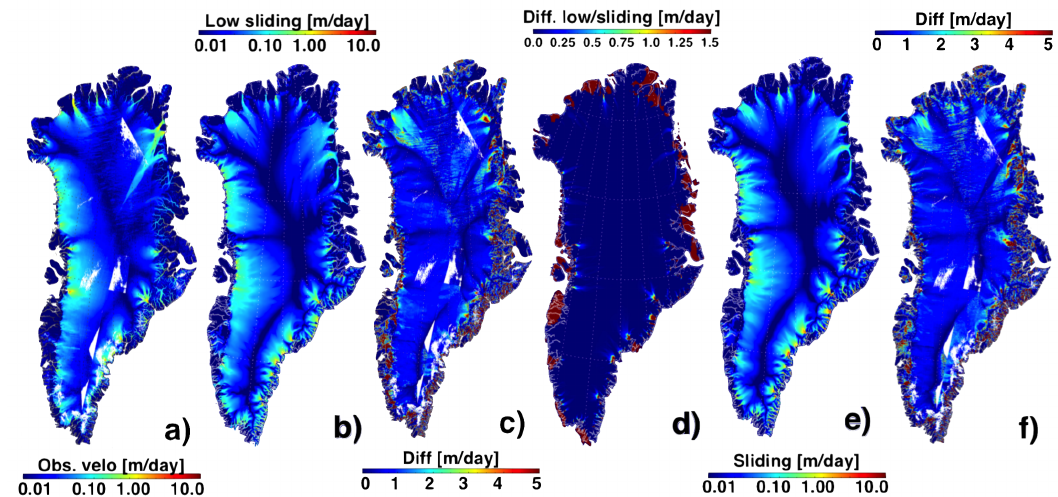
Figure 6. Ice surface velocity in the winter of 2014–2015 (Oct–Mar). ( a ) Mean observed ice velocity. ( b ) Modelled ice velocity in the case of low sliding. ( c ) Difference in observed and low sliding model velocity ( a vs. b ). ( d ) The difference between the modelled ice velocities. ( e ) Modelled ice velocity with sliding included. ( f ) Difference in observed and sliding included model velocity ( a vs. e